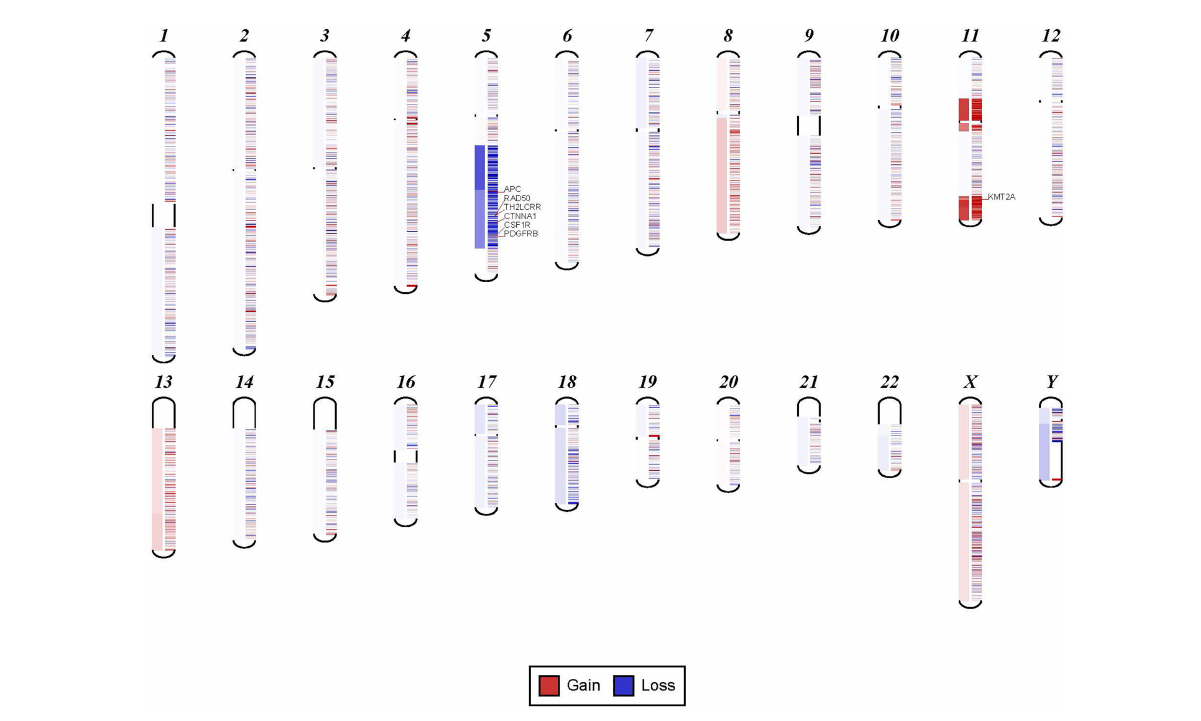
FIGURE 2 | Example for discrepancy in cytogenetic description between NGS fi ndings. The fi ndings visualized here by NGS were described by cytogenetic analysis as “ 48,XY,del(5)(q13q33),+8,+mar[20]. ” NGS showed the 5q deletion and 8q gain and gene ampli fi cation involving chromosome 11, particularly KMT2A gene, which is most likely reported as a marker chromosome. In addition, trisomy 13 was noted by NGS that was not reported by